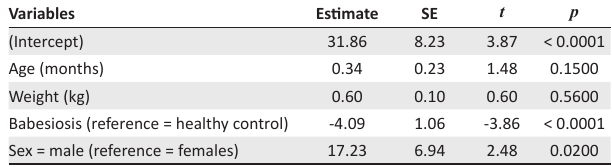
TABLE 2: Estimates from linear models of 25-hydroxyvitamin D concentrations in dogs with babesiosis, exploring the relationship between vitamin D status and disease severity and adjusting for other